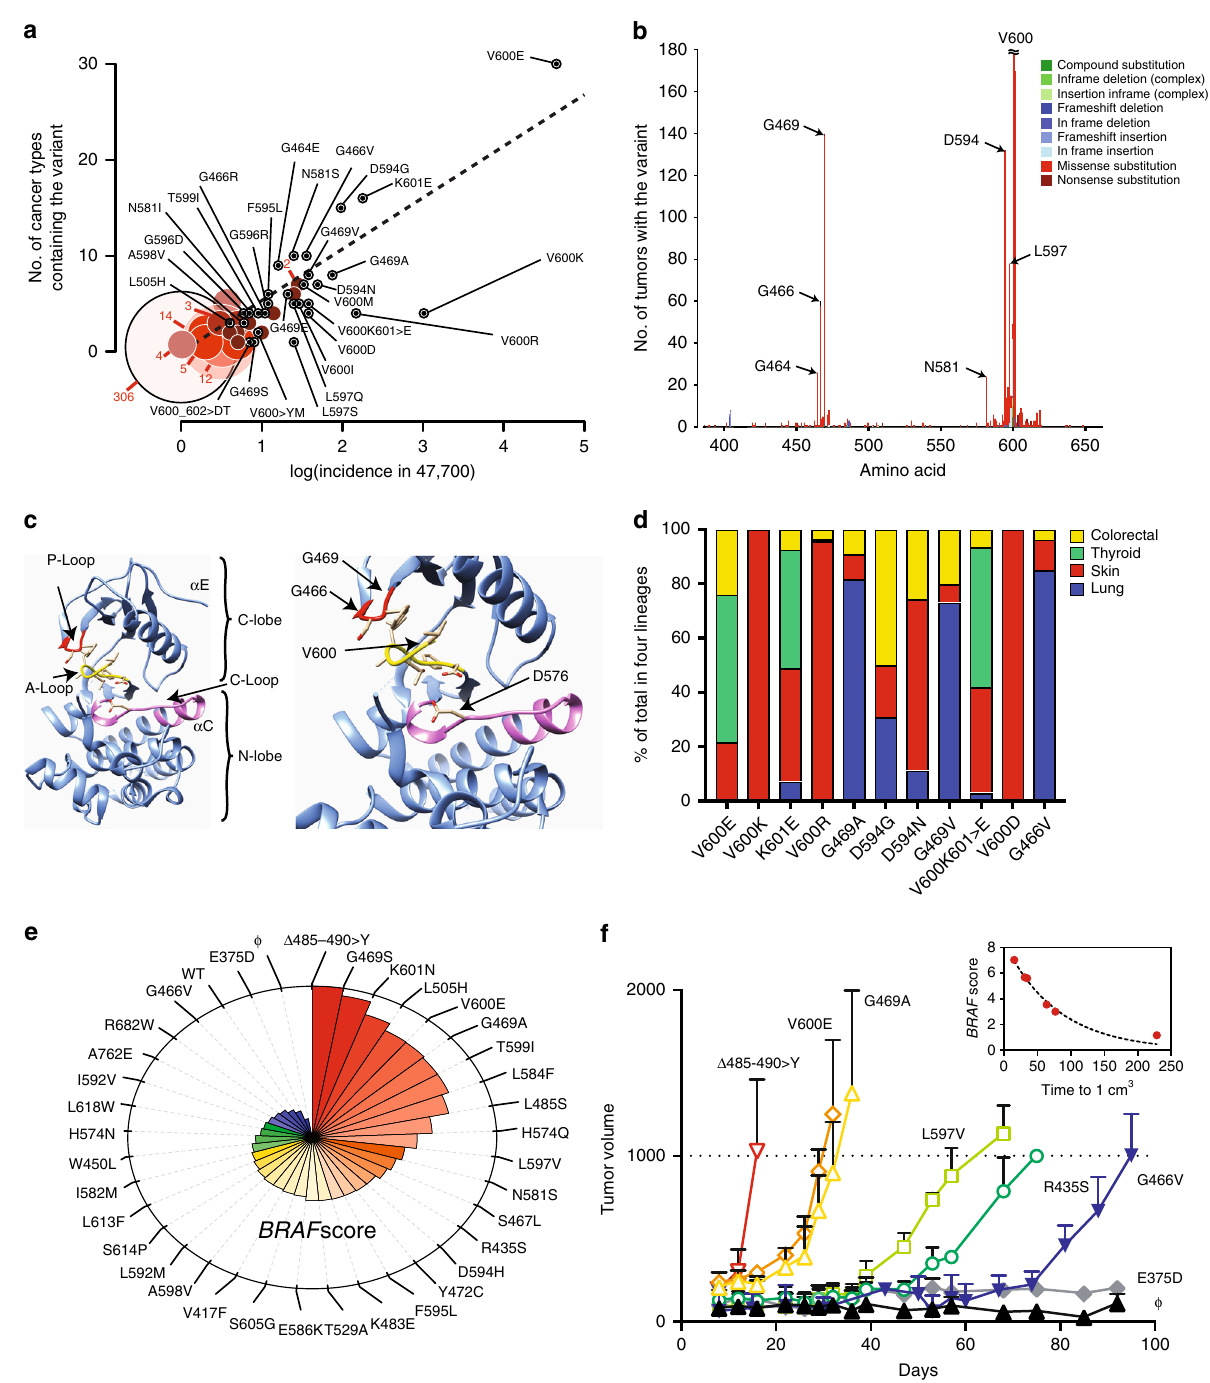
Fig. 1 The landscape of genetic drivers in BRAF features distinct variants. a The size of the circle corresponds to the number of variants at that amino acid position. Variants that occupied a unique position are annotated. The vast majority of BRAF variants were found once in a single cancer type. b , c Secondary (non-V600) variant frequency peaks occur in residues that comprise the A-loop, the P-loop and residues critical for Mg + 2 chelation. The catalytic D576 (C-loop), which is in a cleft between the N- and C-lobes, is shown. d The relative proportion of the 10 most frequent variants in the four most common cancer types are shown. e Clock plot of BRAF signature score in BEAS-2B cells expressing vector control ( ϕ ), wild-type (WT) or 35 BRAF variants. Red and blue represents cells with the most and least BRAF activity, respectively. f BEAS-2B cells stably infected with vector alone ( ϕ ) or vector expressing BRAF alleles were injected into the fl anks of NSG mice and monitored for growth. The association between the BRAF signature score and the time for tumor volume to reach 1 cm 3 is shown in the inset. Tumor volume is expressed as the mean ± s.d. of at least six independent biological